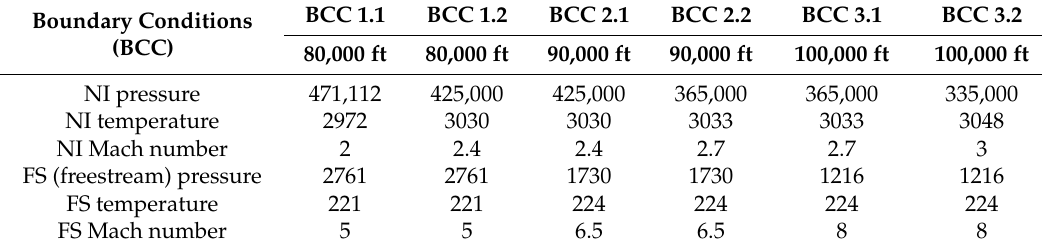
Table 5. Input parameters for the nozzle inlet